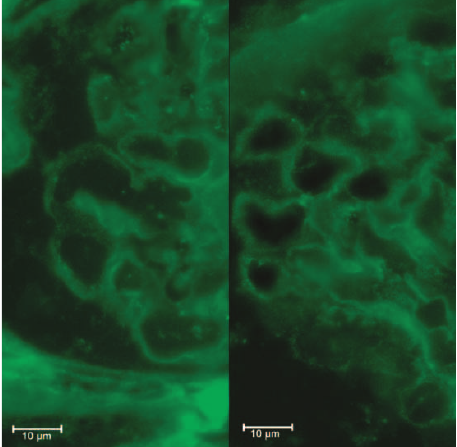
Figure 3. Kidney sections of pre-/post-induction and post- induction-only treated SPHN rats (left) and of rKF3 antigen injected rats (right) show no depositions of rat IgG in the glomerular capillaries by direct fluorescence antibody testing (overexposed